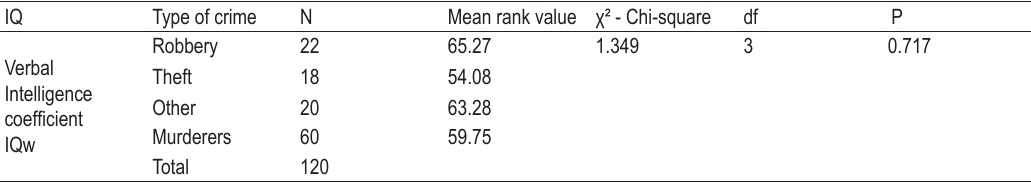
TABLE 4. Testing the signi fi cance of difference in coef fi cients of verbal intelligence (IQw) between groups of inmates with regard to the type of crime by means of factorial analysis of varianceranks (Kruskal-Wallis test)